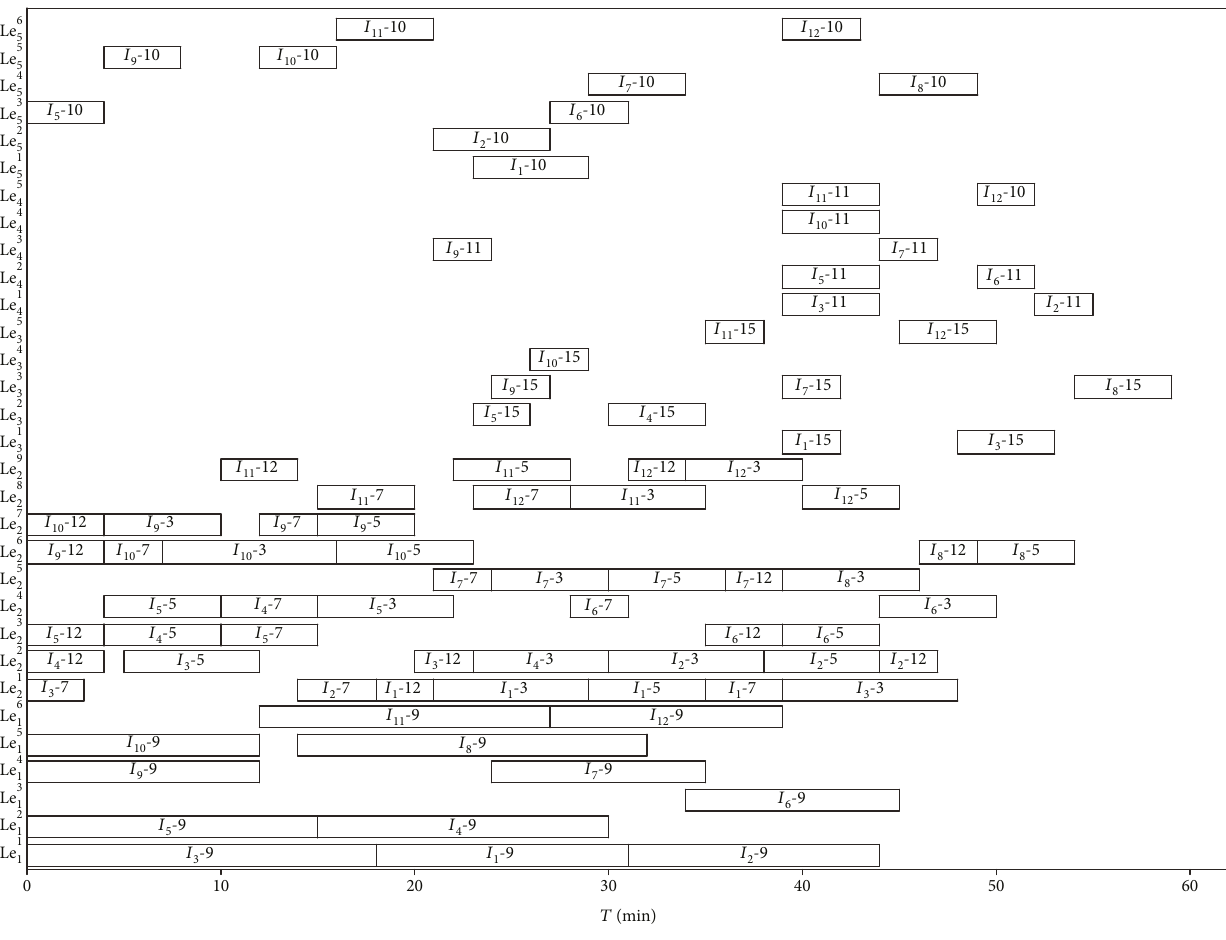
Figure 9: Gantt chart of optimal support resource allocation in deterministic mission case